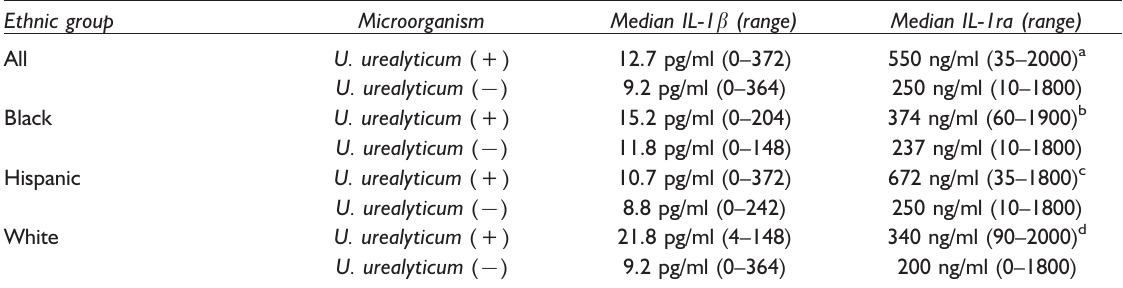
Table 3 Relation between U. urealyticum vaginal colonization, ethnicity and vaginal concentrations of IL-1 b and IL-1ra Ethnic